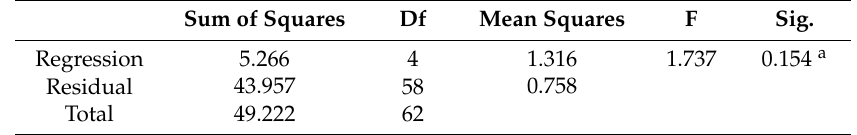
Table 11. The regression analysis of the factors on the aesthetic value evaluation by urban designers. Sum of Squares Df Mean Squares F Sig. Regression 5.266 4 1.316 1.737 0.154 a Residual 43.957 58 0.758 Total 49.222 62